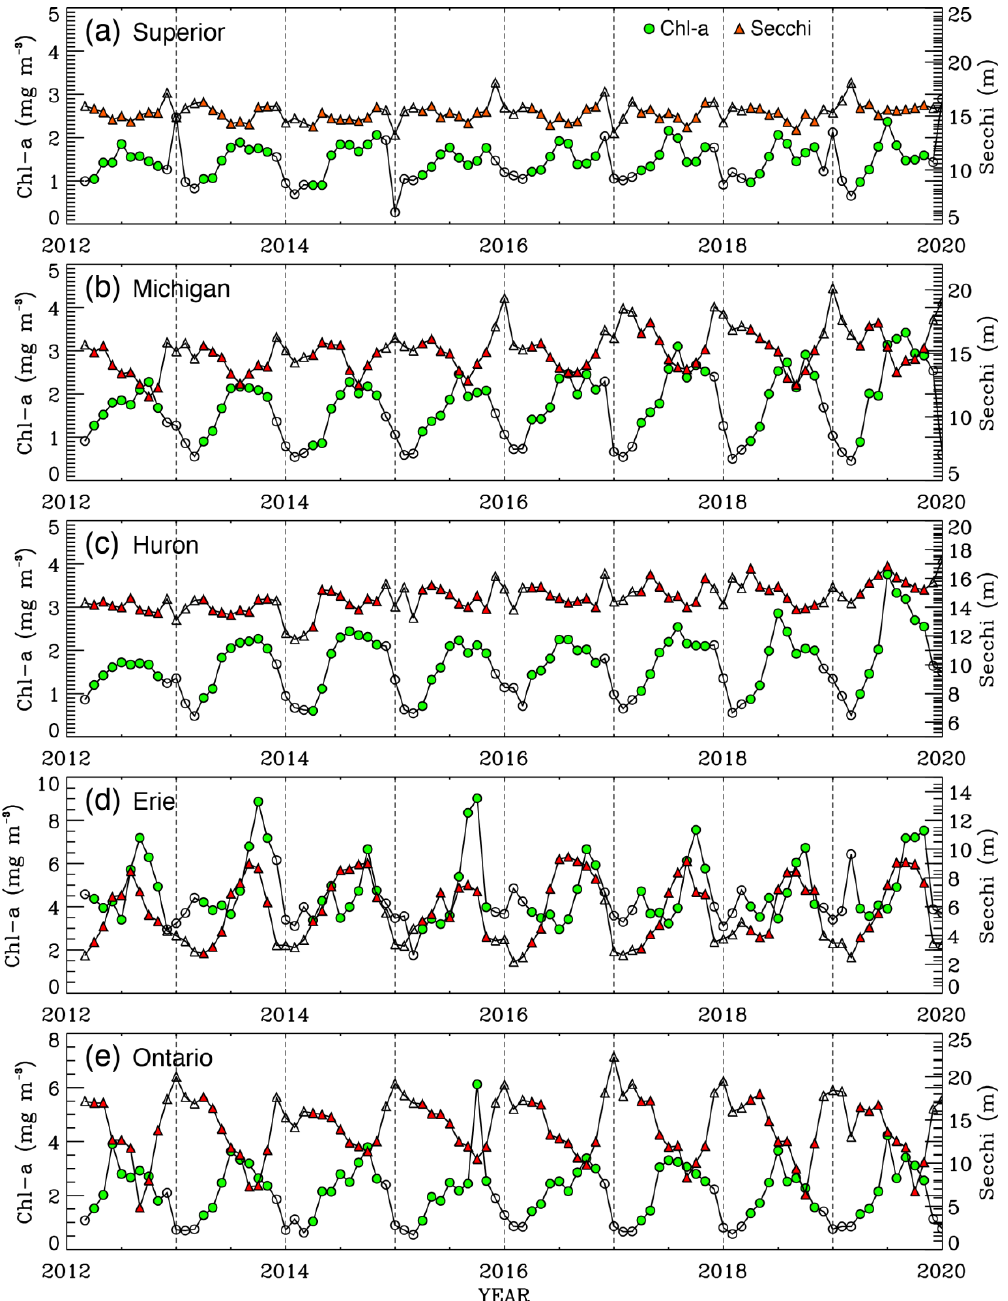
Figure 9. Time series of VIIRS-SNPP-derived monthly Chl-a (green circles) and SD (red triangles)